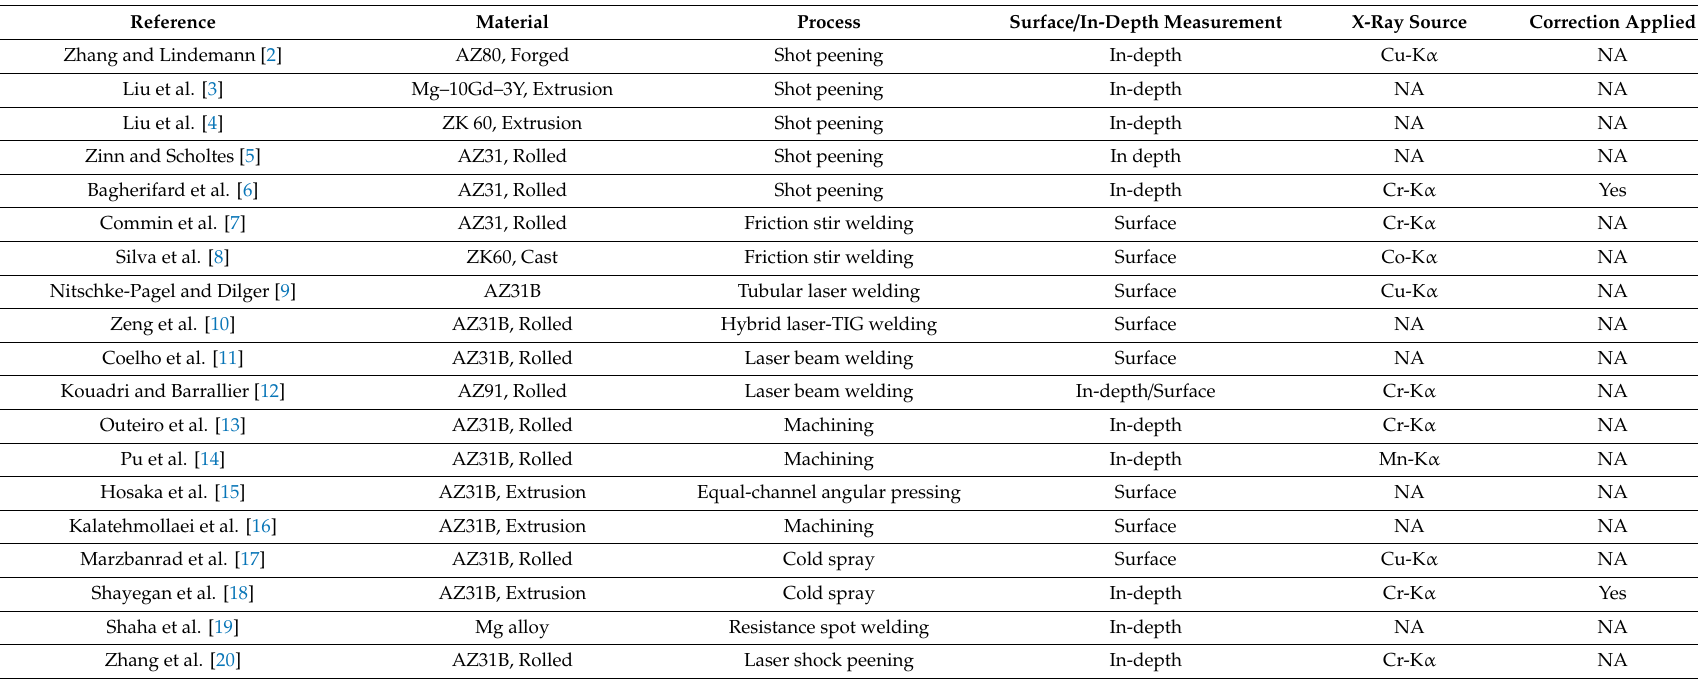
Table 1. Summary of studies on residual stress measurement of Mg alloys using X-ray di ff raction